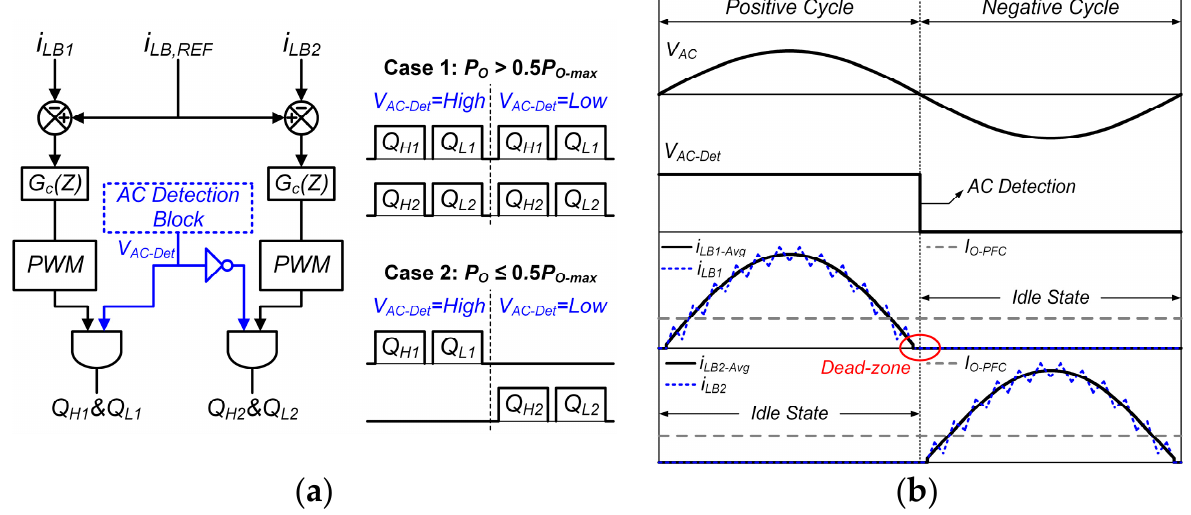
Figure 2. Modified PFC ON/OFF control for interleaved totem-pole bridgeless boost PFC converter. ( a ) Key control block diagram. ( b ) Key waveforms. During Case 2, the role of each module can be swapped every few AC line cycles to obtain symmetric operation.